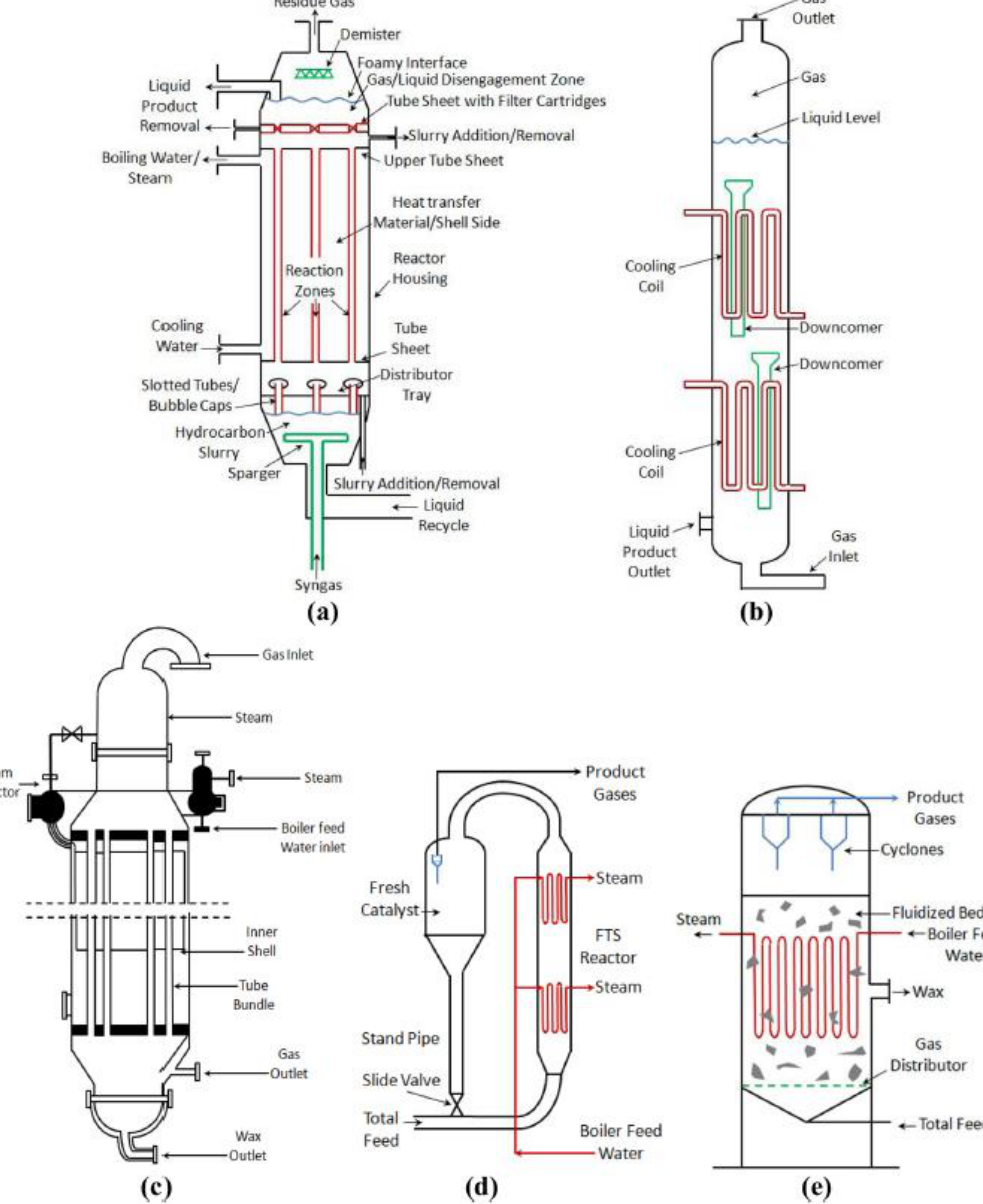
Figure 6. Schematic of commercial reactor designs for FTS. ( a ) Exxon and ( b ) Sasol slurry bubble column reactors (SBCRs), ( c ) multitubular trickle-bed reactor, ( d ) circulating fluidized-bed reactor, and ( e ) fixed fluidized-bed reactor. Reproduced with permission [12].